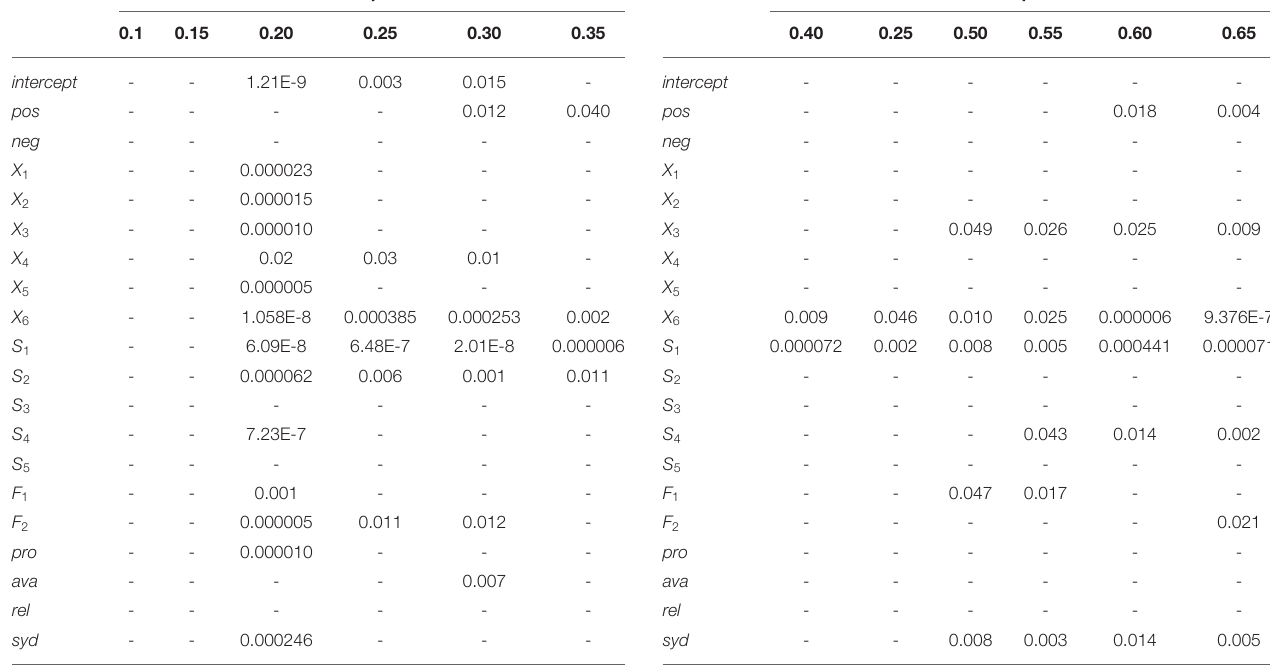
TABLE 7 | Quantile regression coefficient significance Table for each quantile (quantile 0.40 ∼ 0.65).